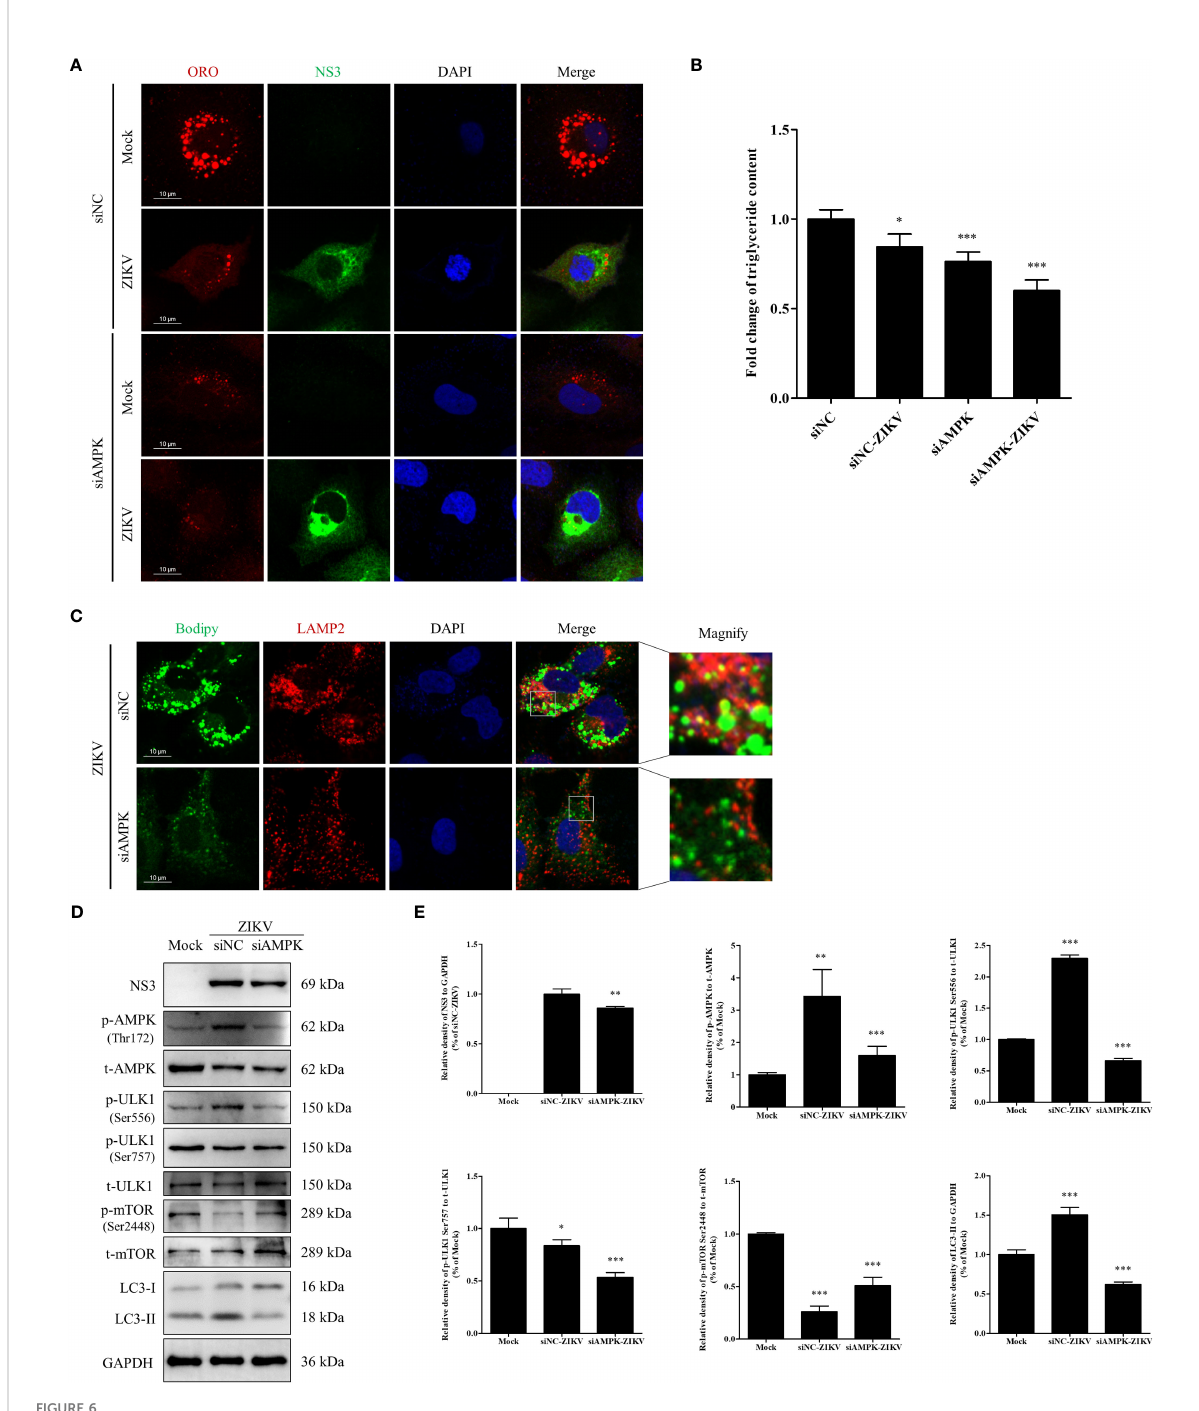
FIGURE 6 Knock-down of AMPK expression inhibits ZIKV infection and lipophagy in Huh7 cells. Huh7 cells were transfected with a scrambled negative control siRNA (siNC) or siAMPK for 48 h and then infected with ZIKV or mock-treated for another 24 h. (A) The cells were fi xed, stained with Oil Red O, and ZIKV NS3 antibody and then observed under a confocal microscope. (B) The intracellular triglyceride content in the mock-treated or infected cells was quantitated using a triglyceride assay kit. (C) The cells were fi xed, stained with BODIPY, and LAMP2 antibody and then observed via confocal microscopy. (D) Western blot analysis to assess the levels of AMPK, ULK1, mTOR, and their corresponding phosphorylated forms. GAPDH was used as a loading control. (E) The intensity band ratios of phosphorylated forms of AMPK, ULK1, and mTOR to respective total protein levels were measured using densitometry. Data are presented as the mean ± SD from three independent experiments. Bars, 10 µm. * p < 0.05, ** p < 0.01, *** p <